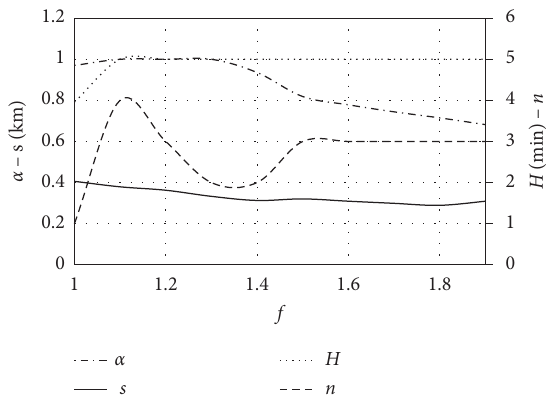
Figure 3: Change of the decision variables with f .